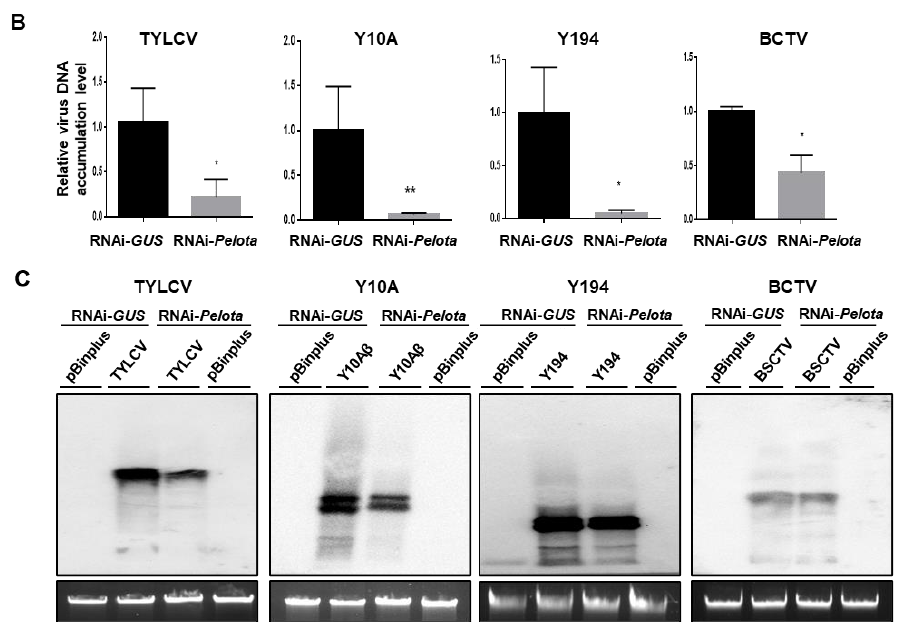
Figure 5. Knockdown of Pelota expression converts a Nicotiana benthamiana plant from a geminivirus-susceptible host to a geminivirus-resistant host. ( A ) Viral symptoms of N. benthamiana plants treated with agrobacterium that contains the construct expressing hairpin RNA targeting Pelota (RNAi- Pelota ) or a hairpin RNA GUS control (RNAi- GUS ), and then agroinoculated with either the pBinPLUS empty vector (mock), an infectious clone of tomato yellow leaf curl virus (TYLCV), tomato yellow leaf curl China virus/tomato yellow leaf curl China betasatellite (Y10A β ), tomato leaf curl Yunnan virus (Y194), or beet curly top virus (BCTV). ( B ) qPCR analysis of viral DNA accumulation in geminivirus- infected RNAi- Pelota - and RNAi- GUS -treated plants. Leaf samples were collected from TYLCV, Y10A β , Y194, and BCTV-infected N. benthamiana plants at 9, 5, 9, and 12 dpi, respectively. Specific primers for TYLCV, Y10, Y194, or BCTV capsid protein were used to quantify the accumulation of viral DNA; 25S rRNA was used as the internal control. Asterisks denote statistically significant differences evaluated with Student’s t test, * p < 0.05, ** p < 0.01. ( C ) Viral DNA accumulation in geminivirus-infected RNAi- Pelota - and RNAi- GUS -treated plants was analyzed by Southern blotting. Leaf samples were collected from TYLCV, Y10A β , Y194, and BCTV-infected N. benthamiana plants at 12, 8, 12, and 9 dpi, respectively. DNA fragment of TYLCV, Y10, Y194, or BCTV capsid protein was used to quantify the accumulation of viral